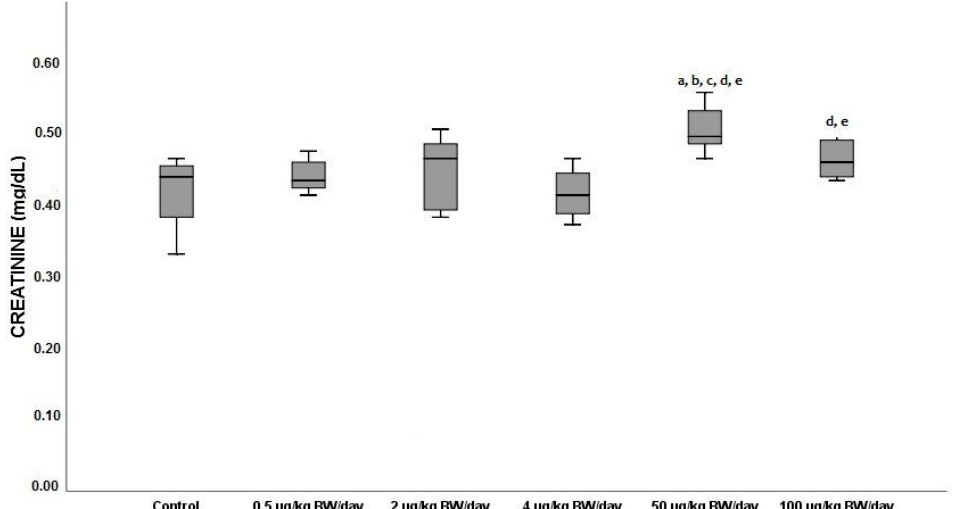
Figure 5. Means ± standard deviations of the serum levels of creatinine (CREAT) expressed in mg/dL, in the different exposure groups. a significant differences vs. control (G0) ( p < 0.05); b significant differences vs. 0.5 µ g/kg BW/day (G1); c significant differences vs. 2 µ g/kg BW/day (G2), d significant differences vs. 4 µ g/kg BW/day (G3); e significant differences vs. 50 µ g/kg BW/day